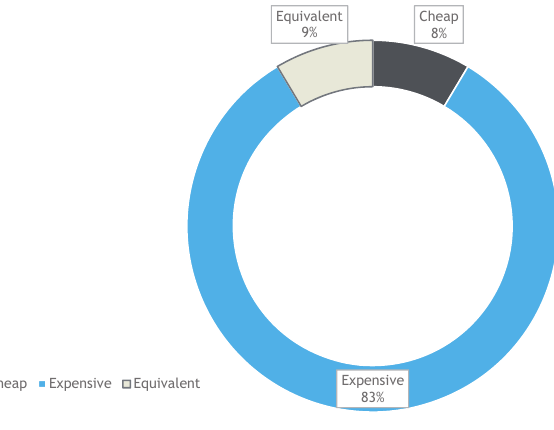
Fig. 3 - Cost of alternate power source. Source: Survey data,